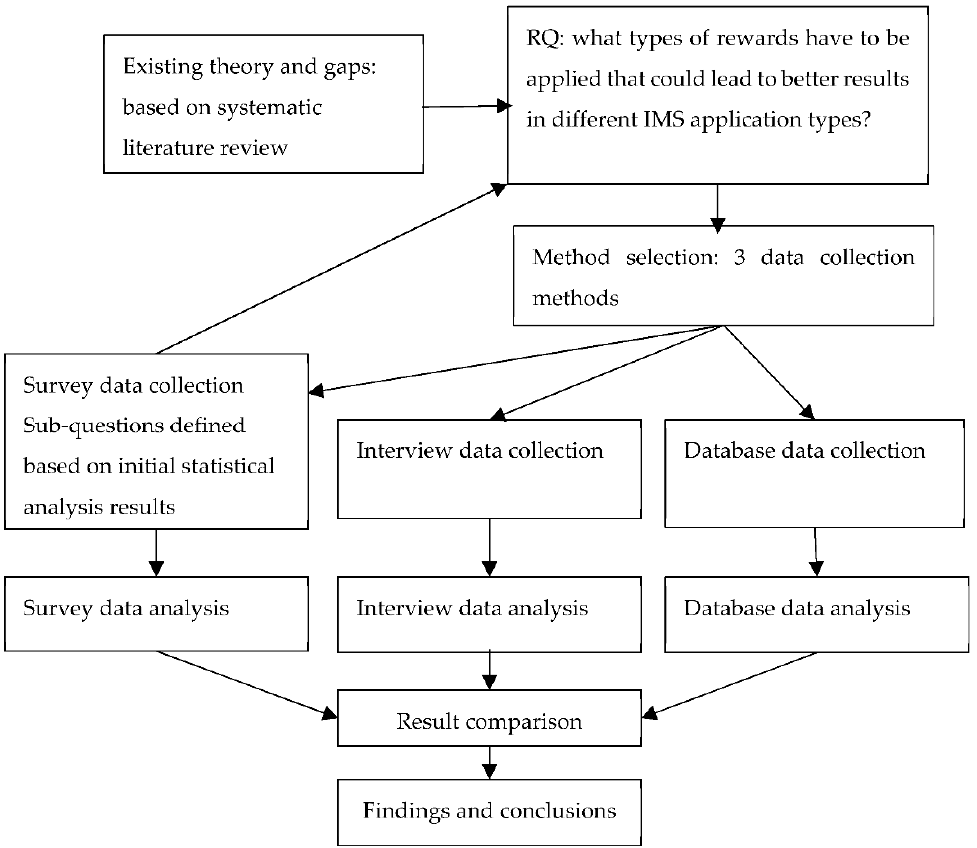
Figure 4. Research design steps. Source: created by the authors.